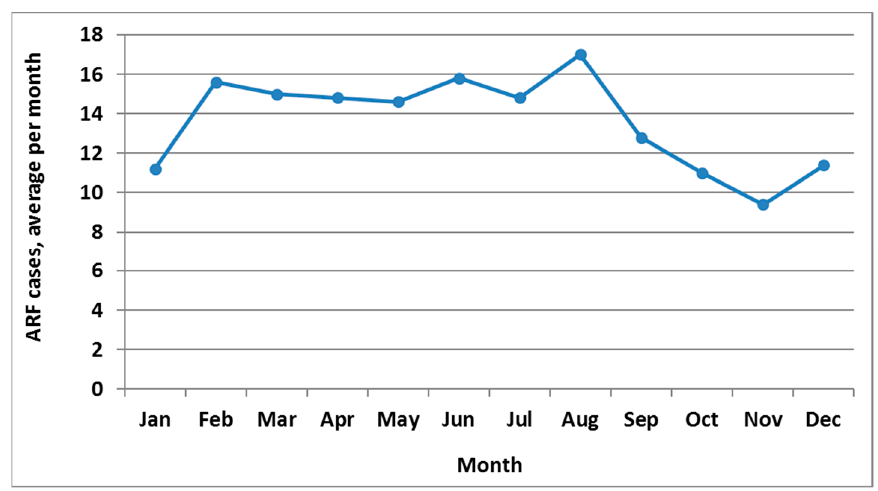
Figure 2. ARF incidence by month, initial hospitalisation numbers, average for 2010 to 2014.